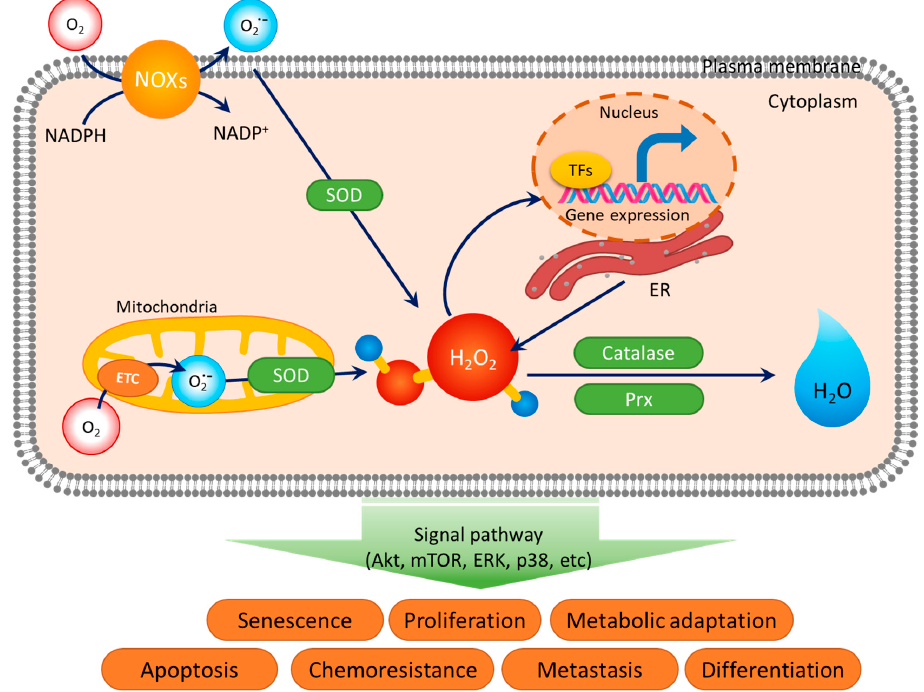
Figure 1. Redox homeostasis between generation and elimination of reactive oxygen species (ROS).